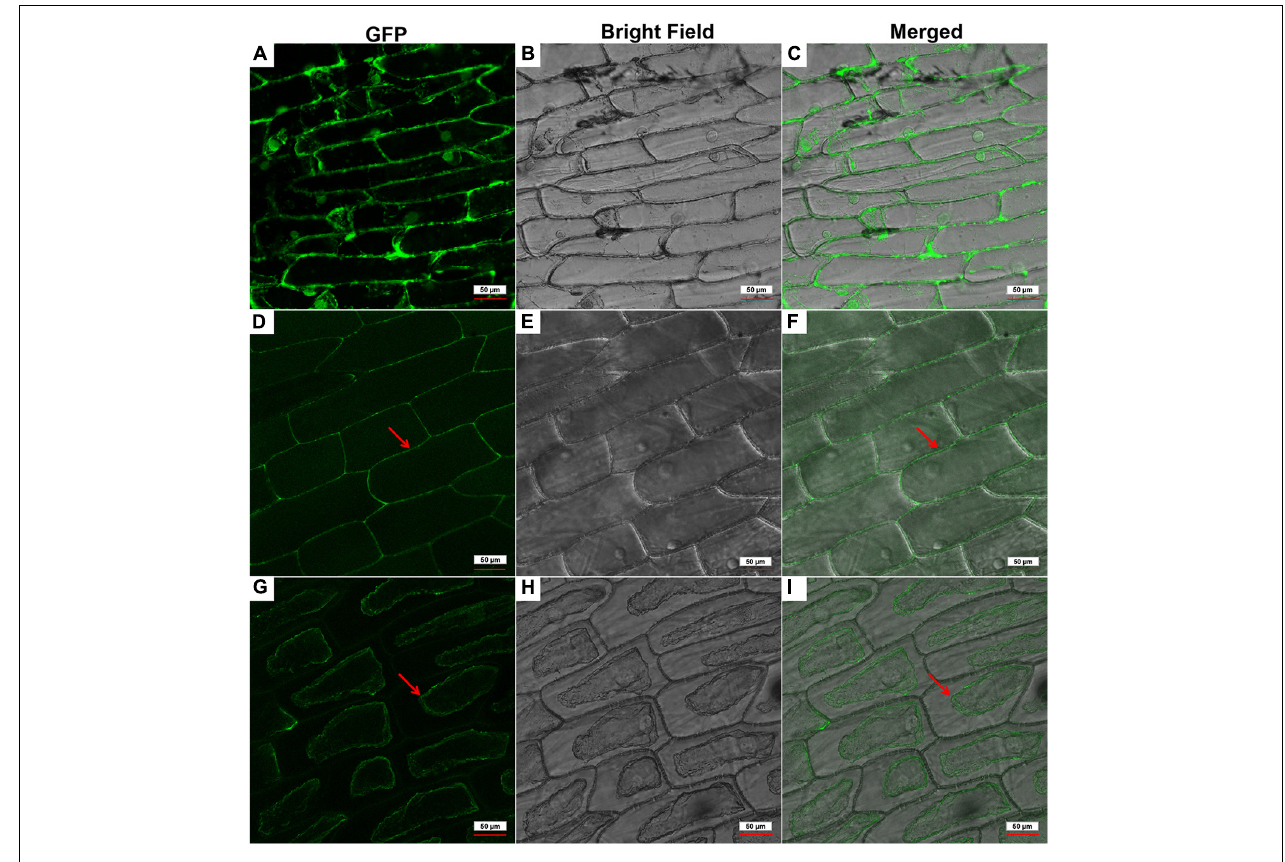
FIGURE 3 | Subcellular localization of the GhPLP2-GFP fusion protein in onion epidermal cells. (A–C) 35S:GFP empty vector was used as a control. (D–F) Red arrows indicated the localization of the GhPLP2-GFP fusion protein. (G–I) Red arrows indicated the localization of the GhPLP2-GFP fusion protein after plasmolysis. Scale bar represents 50 µ